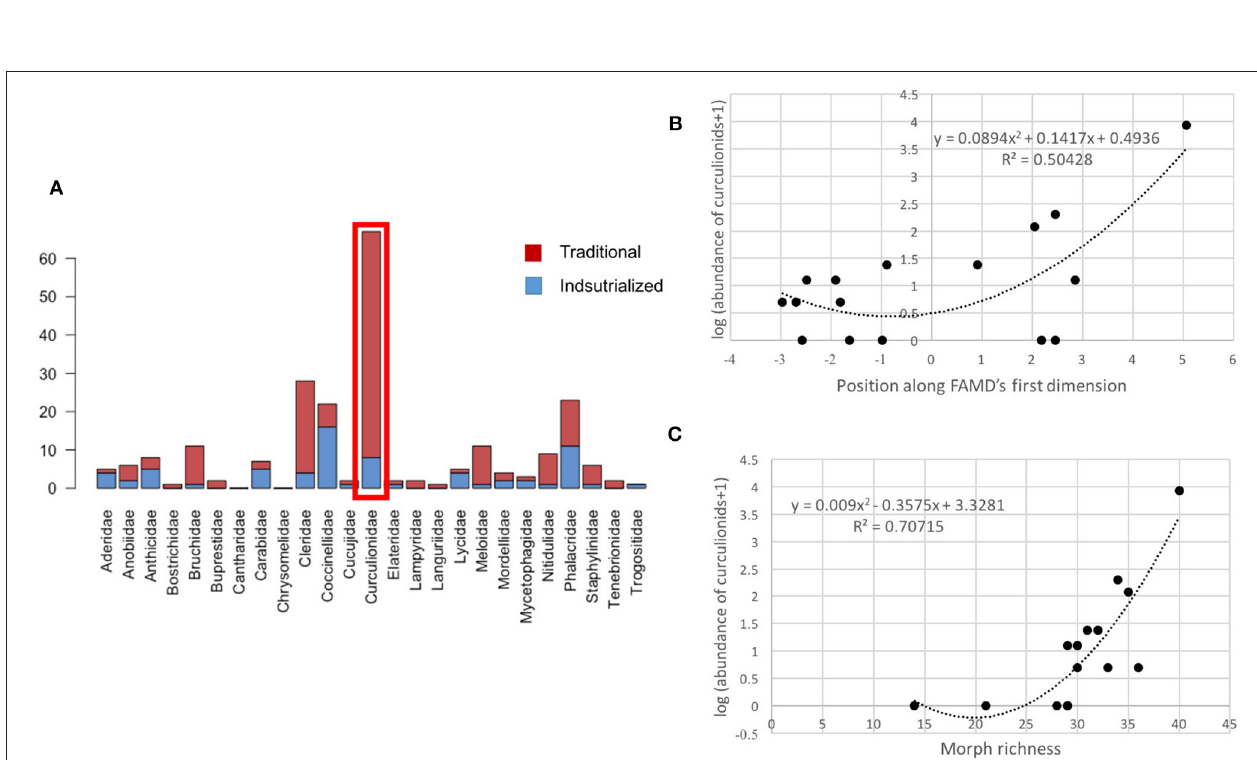
FIGURE 8 | Curculionidae as indicators of management type and coleopteran diversity. (A) abundance of each family in traditional and industrialized plots, (B) polynomial regression of curculionid abundance against management gradient, (C) polynomial regression of curculionid abundance against richness of beetle morphs.